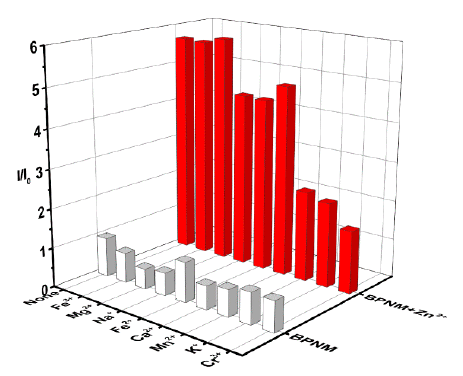
Figure 3. Fluorescence intensity ( I ) responding to other metal ions of nitrates (30 µ M) with zinc ions (30 μ M) existed or not. I 0 is the fluorescence intensity of BPNM (30 μ M).